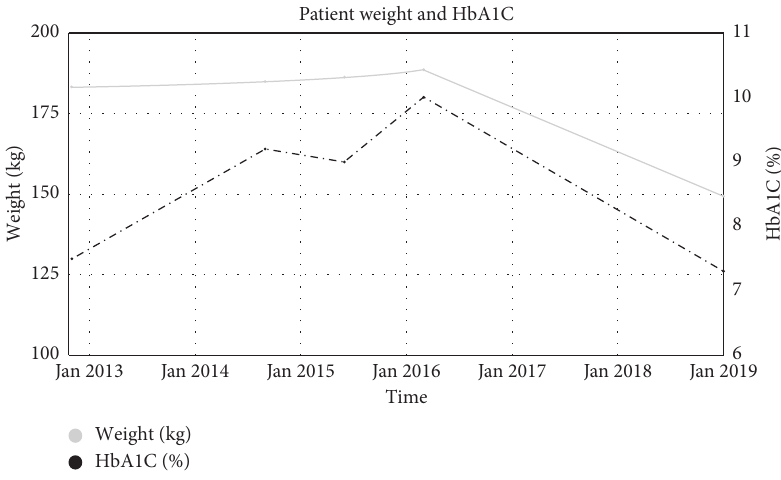
Figure 3: Patient weight and hemoglobin A1C graphed over